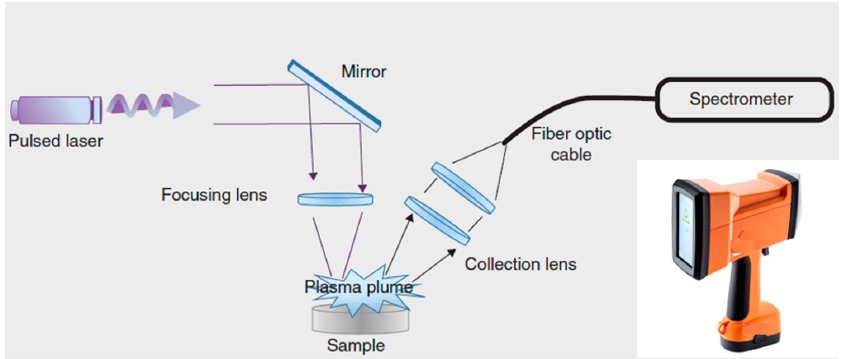
Figure 9. Schematic diagram explaining the principle of portable LIBS, with a photo of the instrument in the inset, modified from [96].